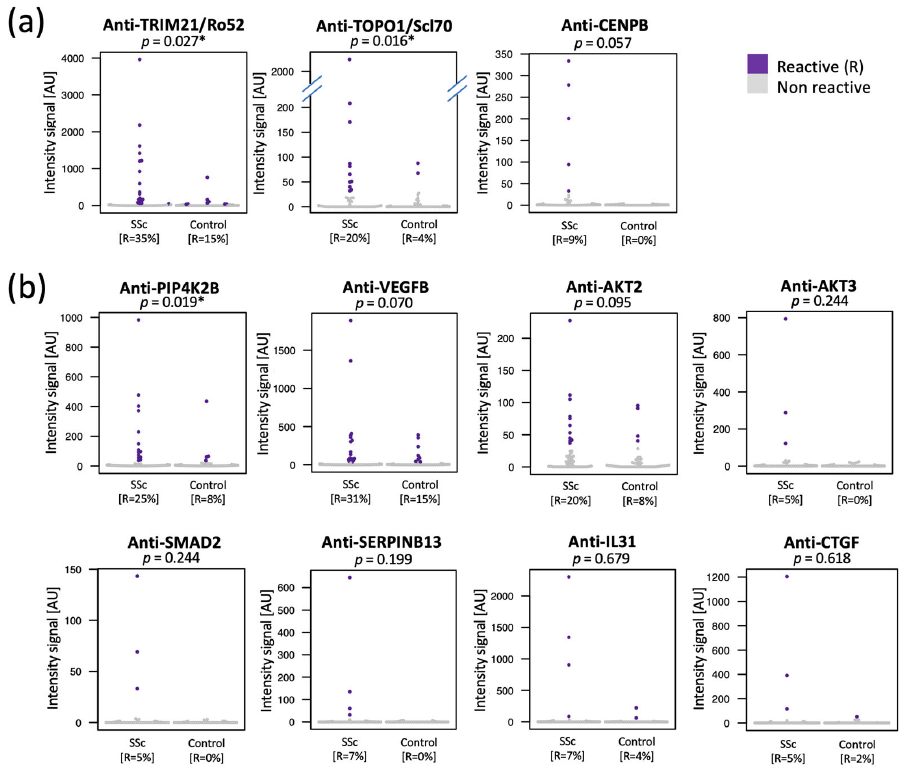
Figure 2. Autoantibodies with higher prevalence in SSc patients. The panel collects the 11 autoan- tibodies showing higher prevalence in plasma of SSc patients compared to controls. ( a ) Three of the autoantibodies are already well-known in the context of SSc. ( b ) Eight autoantibodies bound to pro- teins involved in fi brosis. The dot plots show the intensity signals detected for each autoantibody in each sample. Each dot represents one sample. Purple dots indicate samples where the speci fi c auto- antibody passed the cuto ff for reactivity, and therefore, are de fi ned as reactive. The p -values refer to Fisher´s Exact test; [*] is used for p < 0.05, cuto ff for signi fi cance.